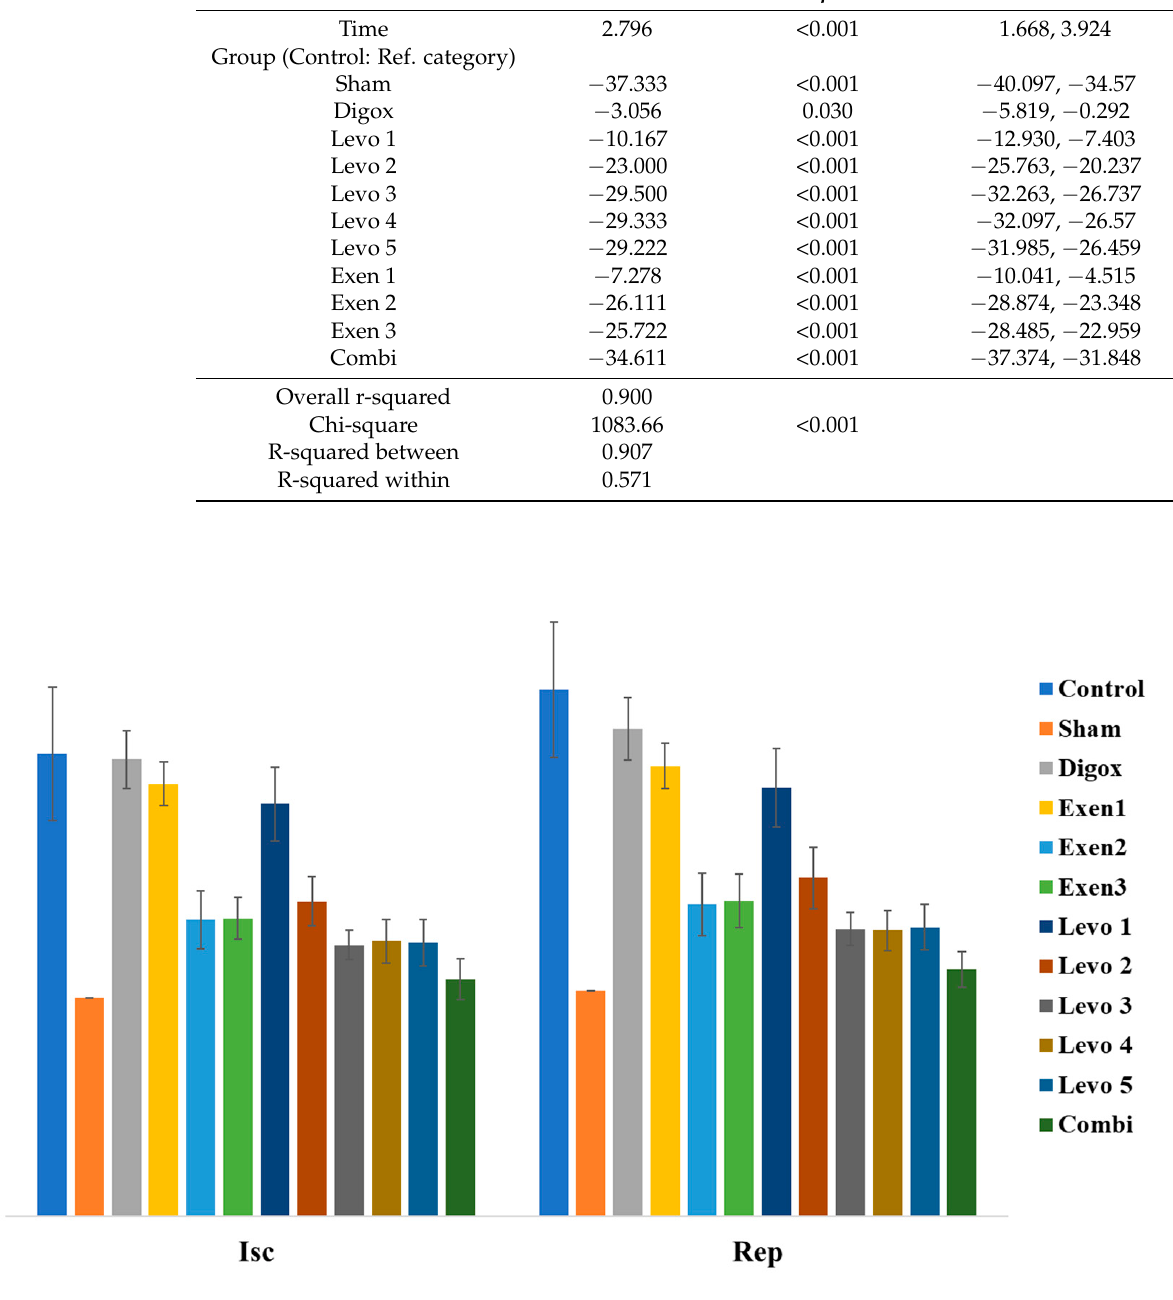
Figure 15. Sections of the hearts of all groups. A one-way ANOVA was performed to assess possible differences of Risk Area/Total Area (R/T) among groups. There was not a significant main effect of group for Risk/Total (F = 1.109, p = 0.363). (Tables 14 and 15, Figure 16).